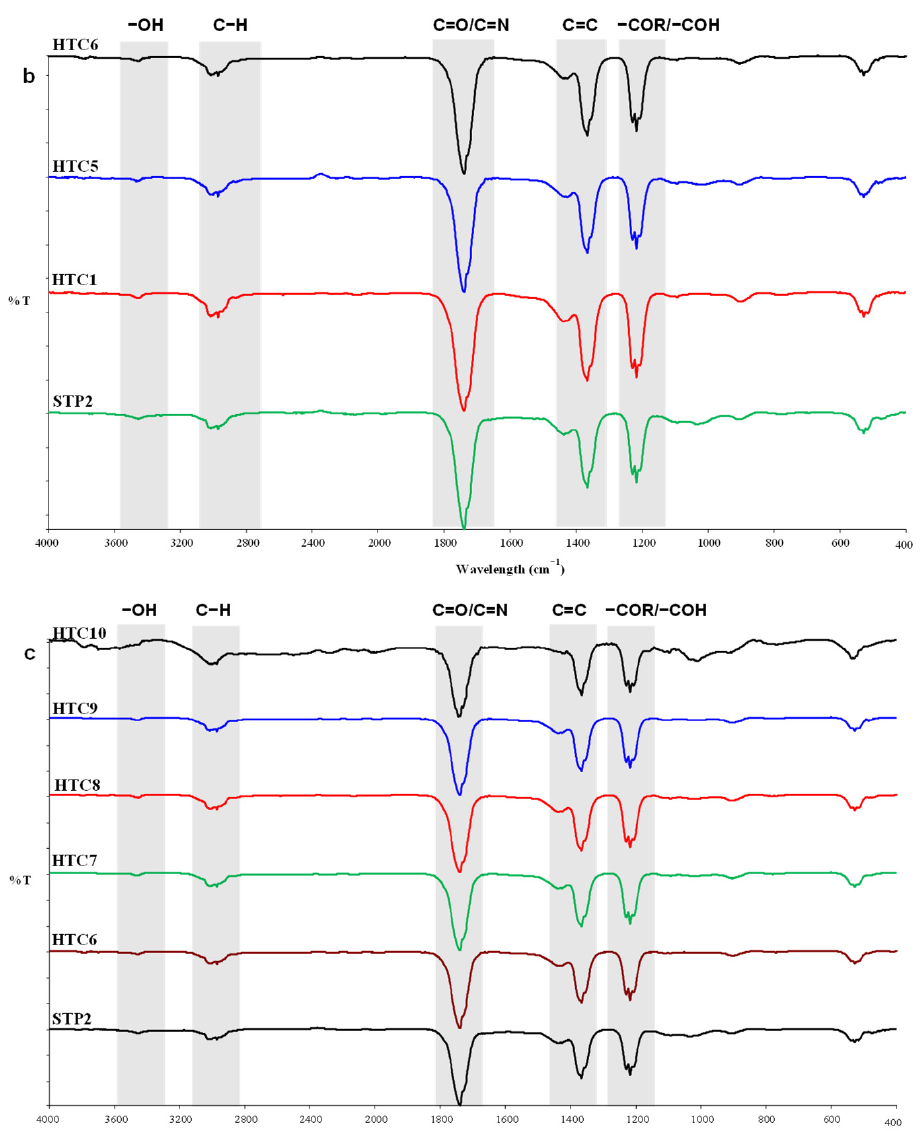
Figure 5. FTIR spectra of hydrochar obtained at different ( a ) HTC temperatures; ( b ) solid loading ratios and; ( c ) reaction times.